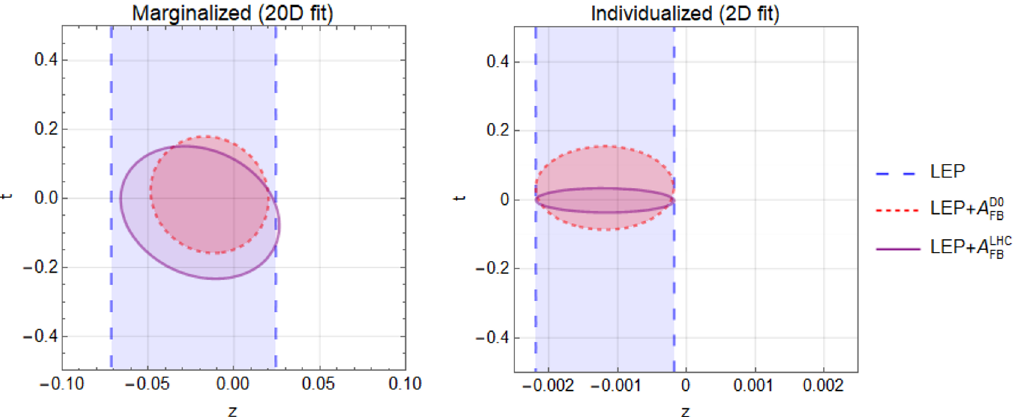
Figure 2 . Allowed regions (corresponding to ∆ χ 2 = 1 ) for the z and t combinations of vertex corrections, see eqs. (3.9) for their definition. The blue vertical band is obtained using LEP data and the rest of traditional pole observables discussed in section 3, whereas the purple and orange ellipses add the FB asymmetry measurements at LHC and D0 respectively (see main text for details). The left panel is obtained marginalizing over the remaining EFT parameters, cf. eq. (2.6), whereas the right panel is obtained setting all of them to zero. Note the horizontal scale is not the same in both